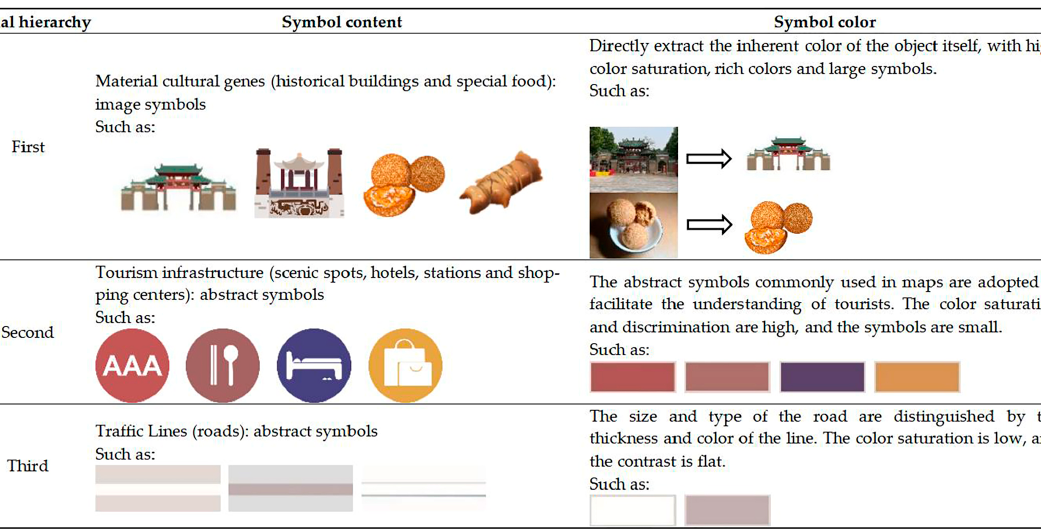
Figure 5. Material symbol and visual